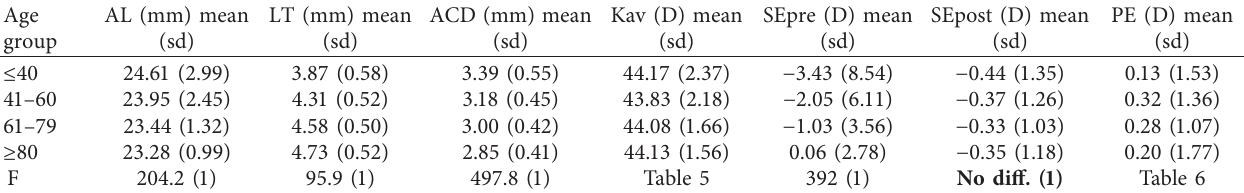
Table 4: Segmentation by age of the biometric parameters, spherical equivalents (SE1 and SE2), and PE.